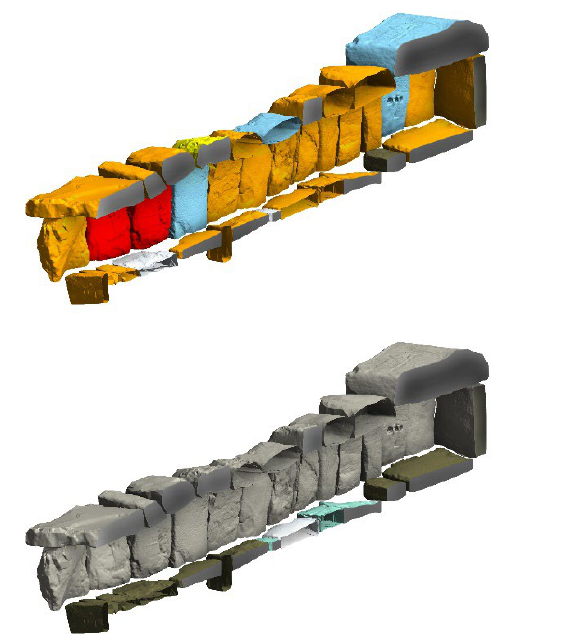
Figure 6. Colorization of the stones based on their material (top) and whether they have been moved or not (bottom)